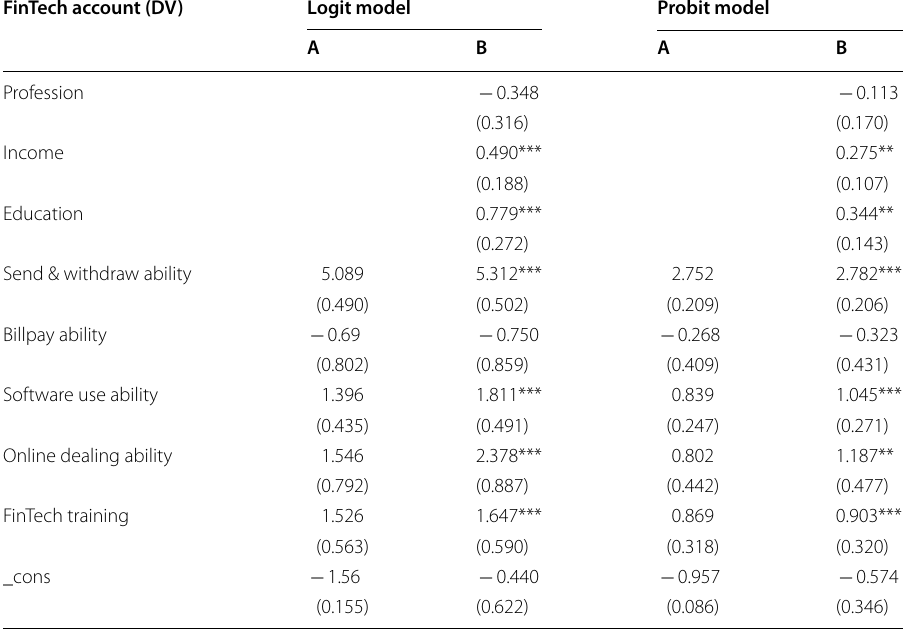
This model presents the association between financial literacy and FinTech access. Part A of the logit model shows log-likelihood, LR chi 2 (5) is 679.05, and model fits at 65% Pseudo R 2 value; where part B shows